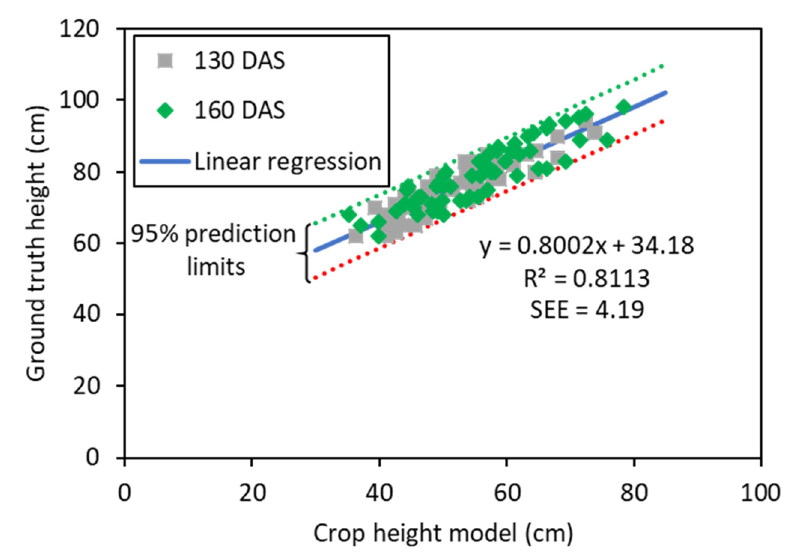
Figure 3. Correlation between computed crop height model and observed ground truth height measurements at two time points.